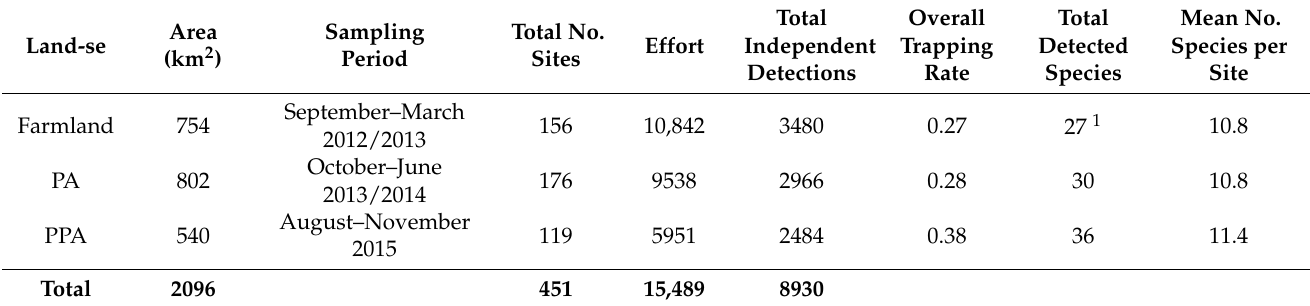
Table A1. Summary of the camera trap surveys conducted on the farmland, protected area (PA) and private protected area (PPA) in the Karoo, South Africa. Area is the total extent (km 2 ) of each land-use. Camera trap failure indicates the proportion of camera traps that failed, due to software malfunction or physical damage, in each survey. Effort is the total number of days (24 h) camera traps were active in each land-use. The total independent detections is the sum of independent photographs ( ≥ 30 min) of all target species per survey, and the overall trapping rate is the number of independent detections divided by the total number of trap nights.